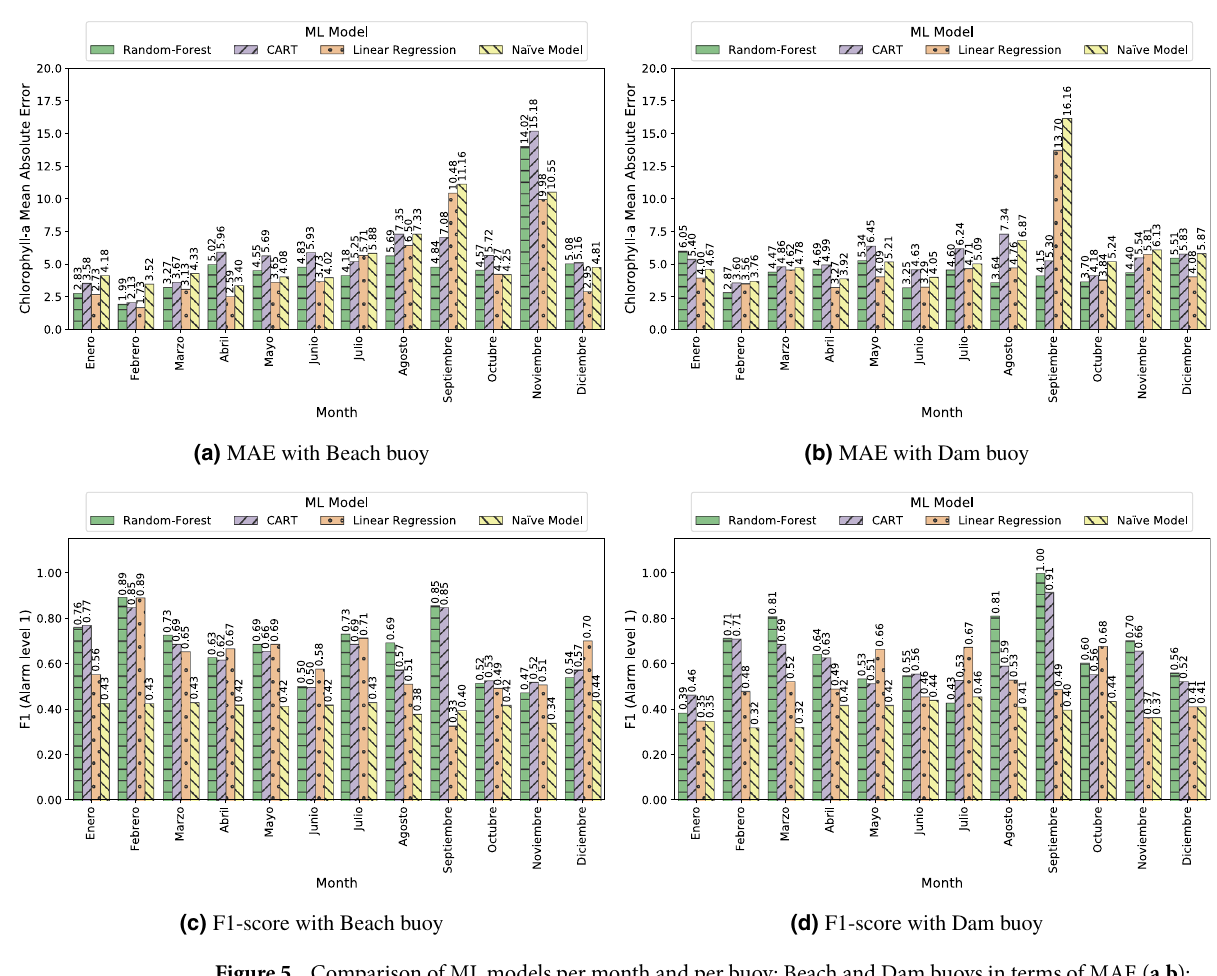
Figure 5. Comparison of ML models per month and per buoy: Beach and Dam buoys in terms of MAE ( a,b ); Beach and Dam buoys in terms of F1-score ( c,d